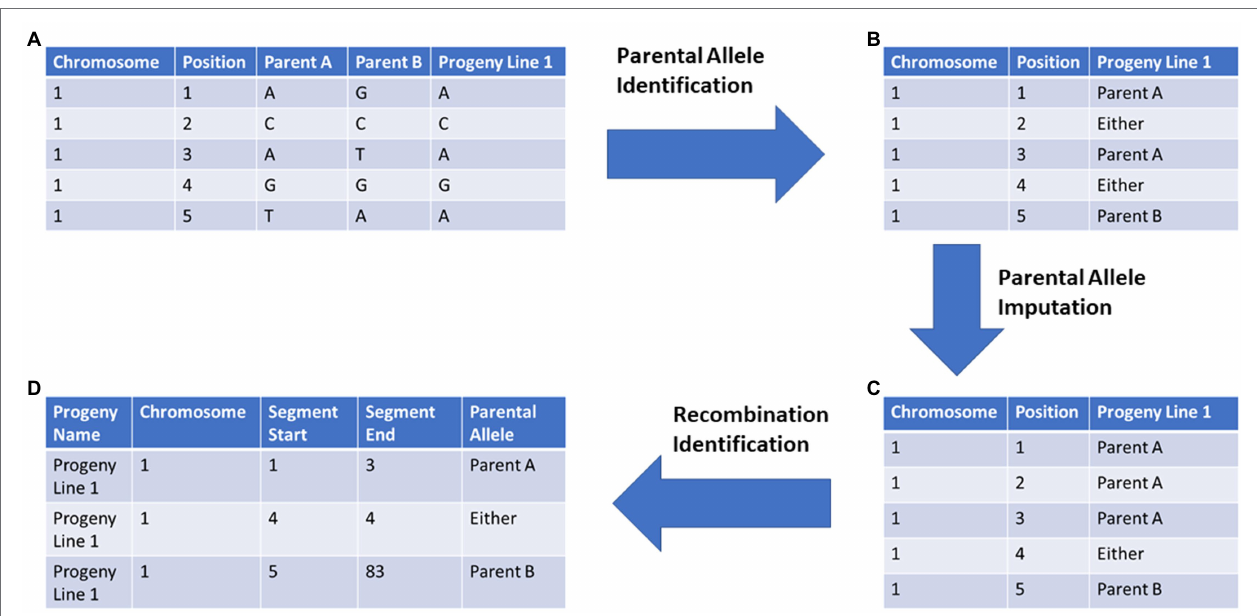
FIGURE 1 | General workflow of Parental Allele Tracing, Recombination Identification, and Optimal predicTion (PATRIOT) input feature preparation for implementation in genomic selection: (A) Raw marker data are provided for both parent and progeny genotypes, (B) parental alleles encoded for those markers which can be conclusively traced to a specific parent, (C) alleles previously not assigned to a specific parent are imputed based on flanking markers, (D) those chromosome segments identical-by-descent from each parent are compiled. The “Position” column refers to the marker order and is provided only for demonstration